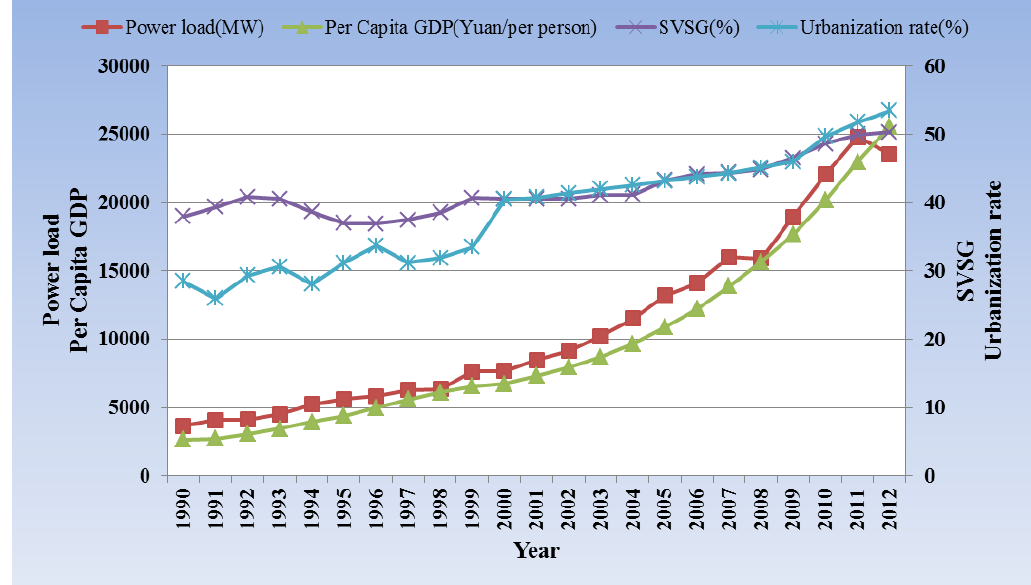
Figure 3. Development trend of annual maximum power load, per capita GDP , SVSG and urbanization rate of Hubei Province from 1990 to